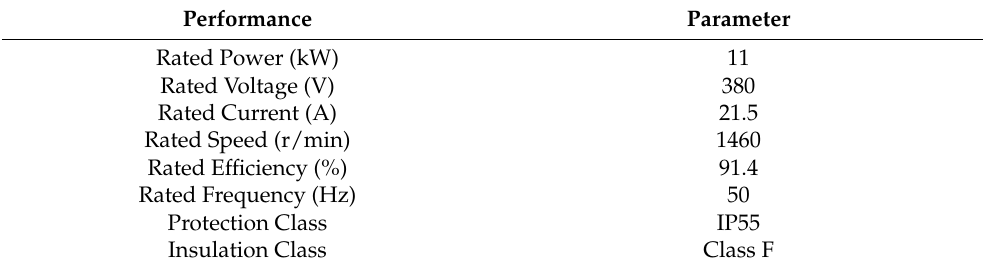
Table 1. Motor performance